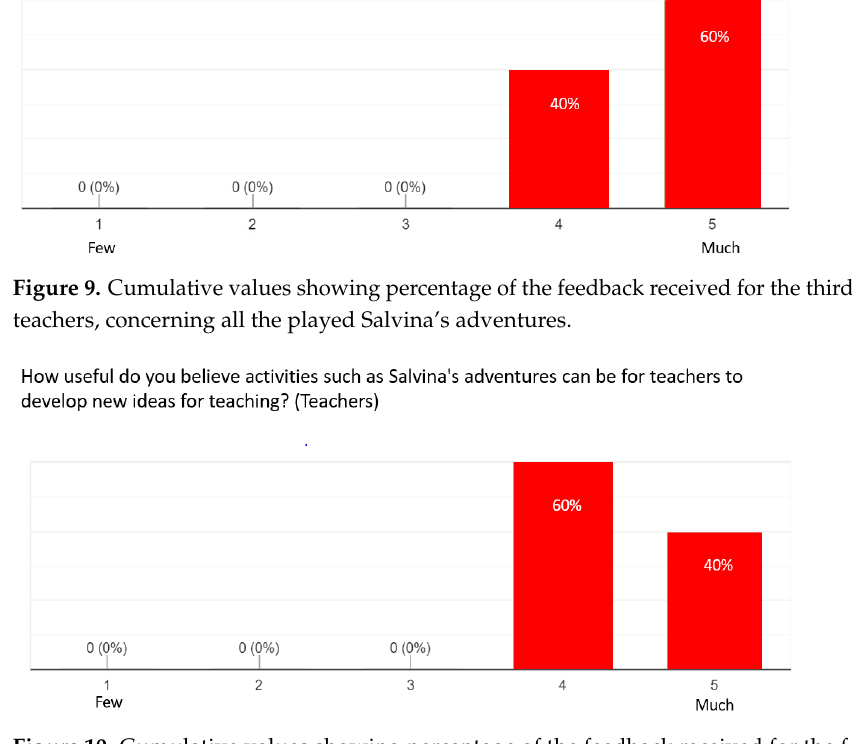
Figure 10. Cumulative values showing percentage of the feedback received for the fourth question from teachers, concerning all the played Salvina’s adventures.